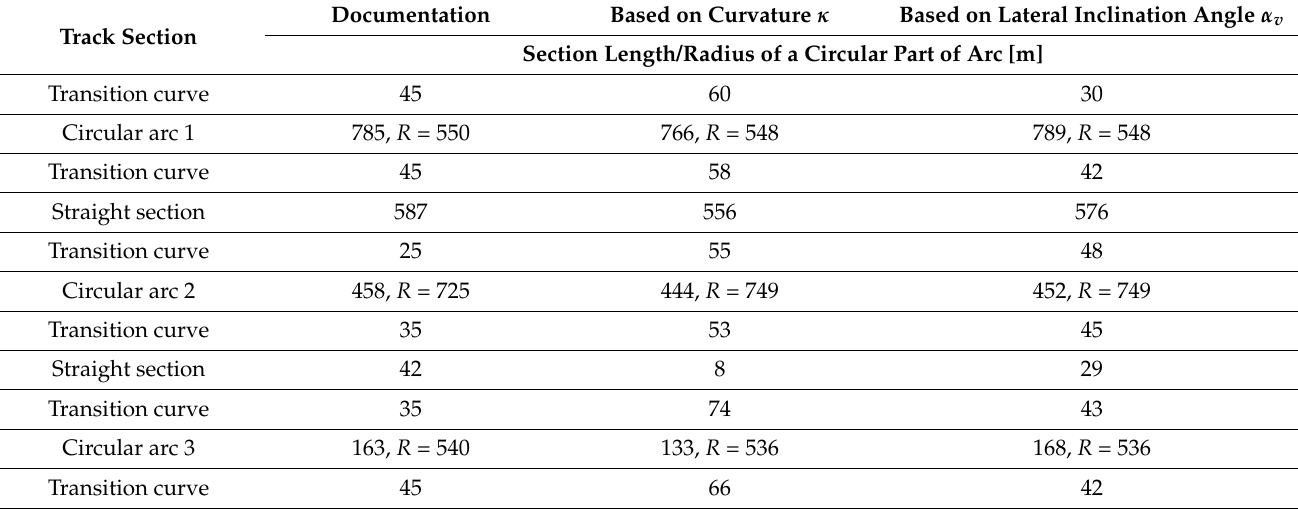
Table 1. Results of railway line section geometry